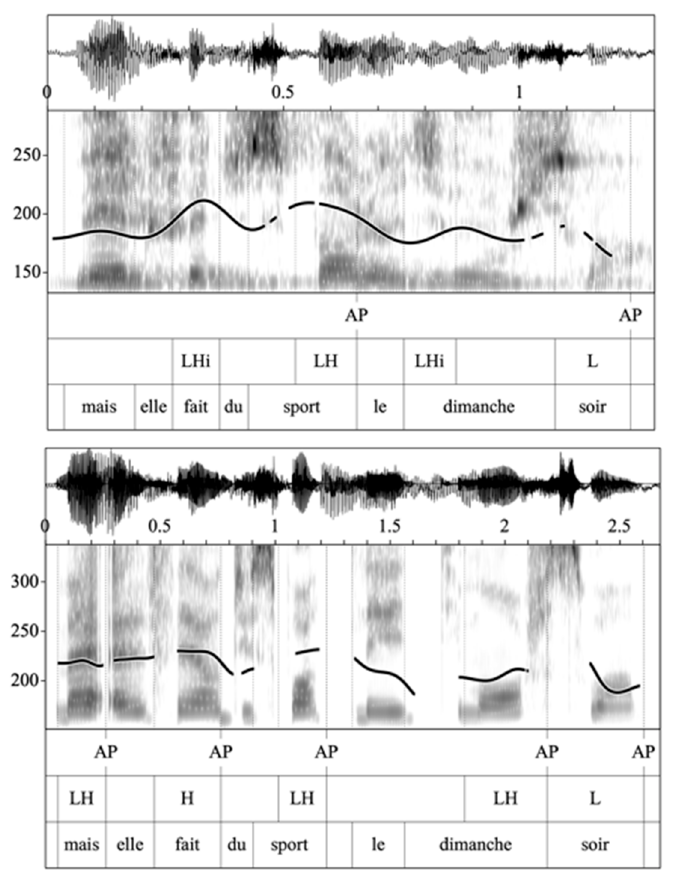
Figure 1. Target sentence 4 realized by a native speaker (upper panel) and by a monolingual German learner (lower panel). 2